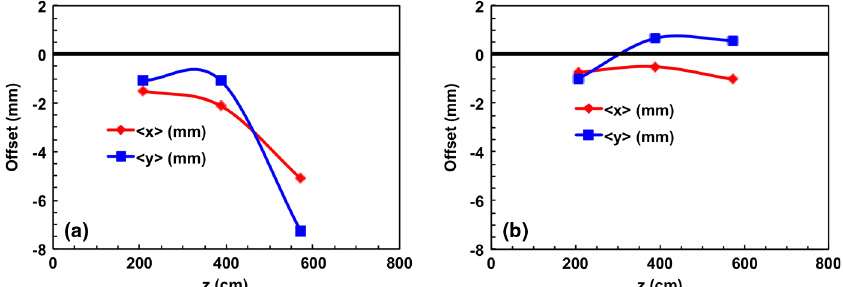
FIG. 6. Measured beam centroid offsets with (a) initial dipole settings for the uncorrected case; (b) corrected centroid offset. Each set was measured only operating the first four induction cells and their nested solenoids with tune [Figs. 2(a) and 5(a)]. The number of betatron oscillations of